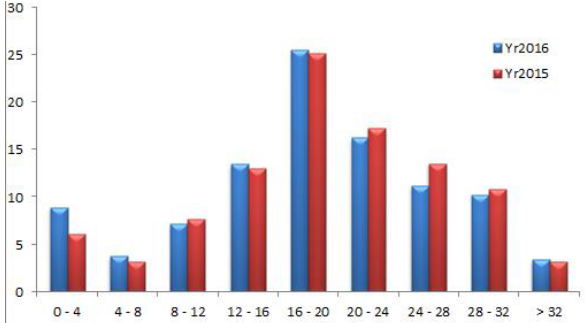
Figure 4. Height class distribution of the